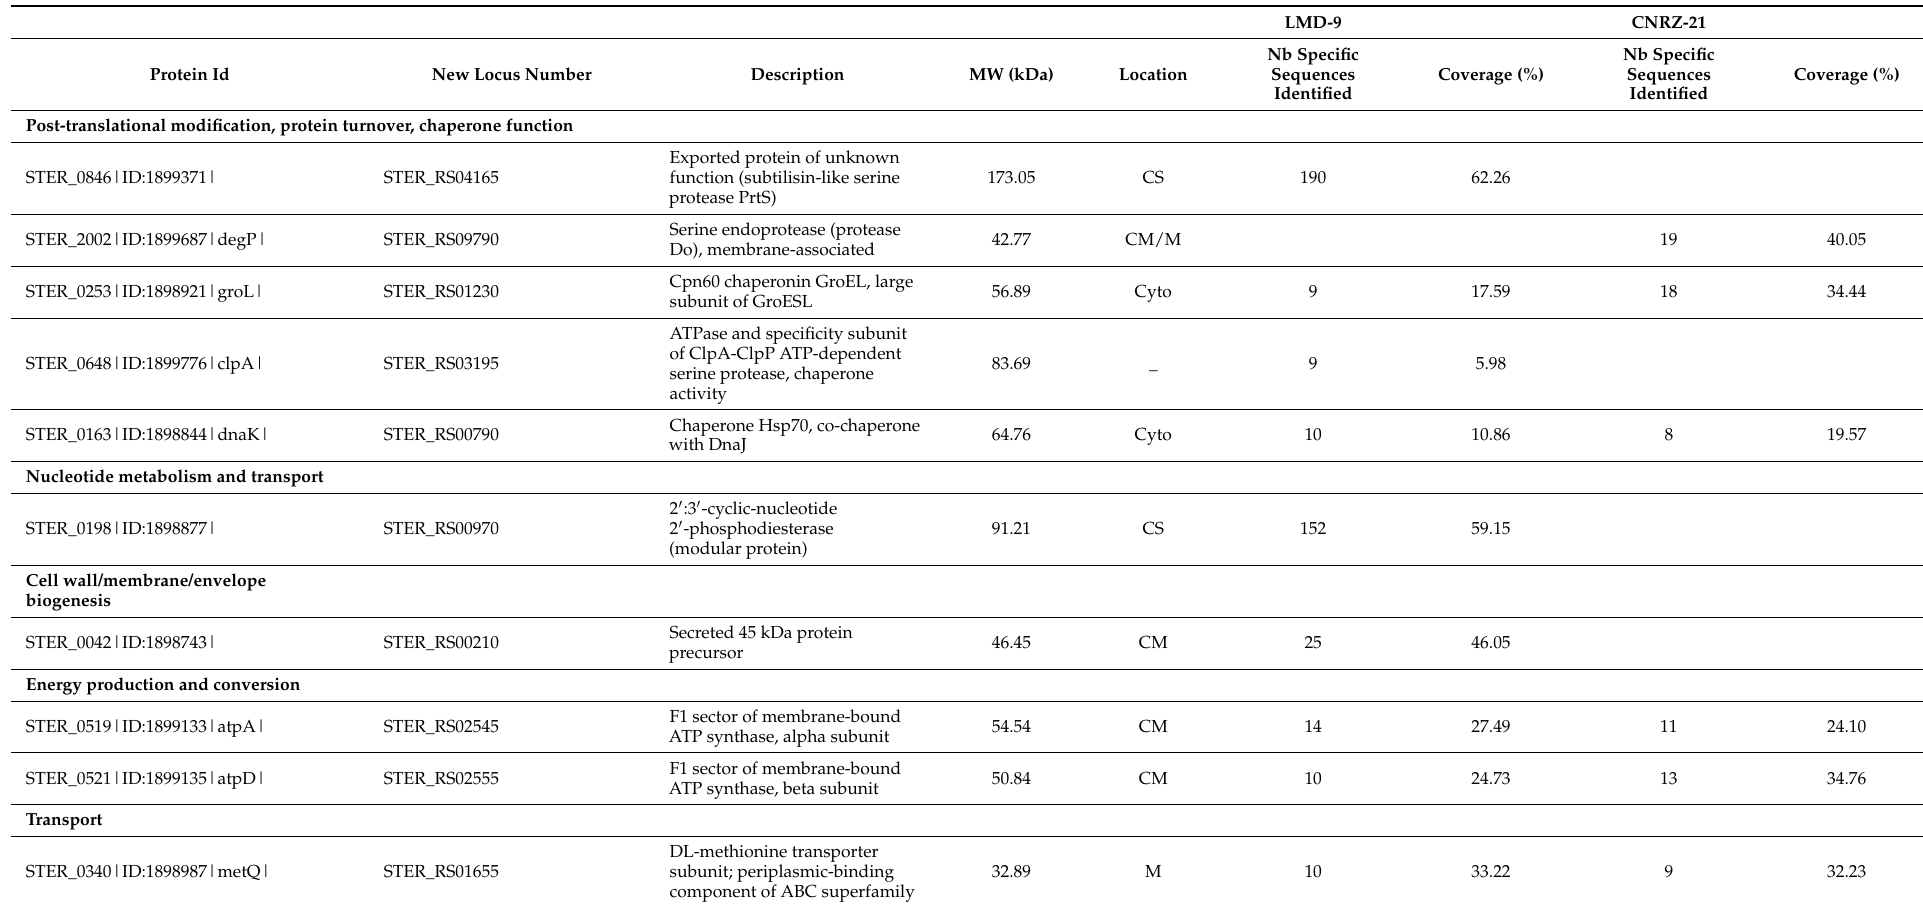
Table 2. Identification of proteins via LC-MS/MS analysis of peptides obtained after peptic shaving followed by trypsinolysis of S. thermophilus LMD-9 and CNRZ-21N.